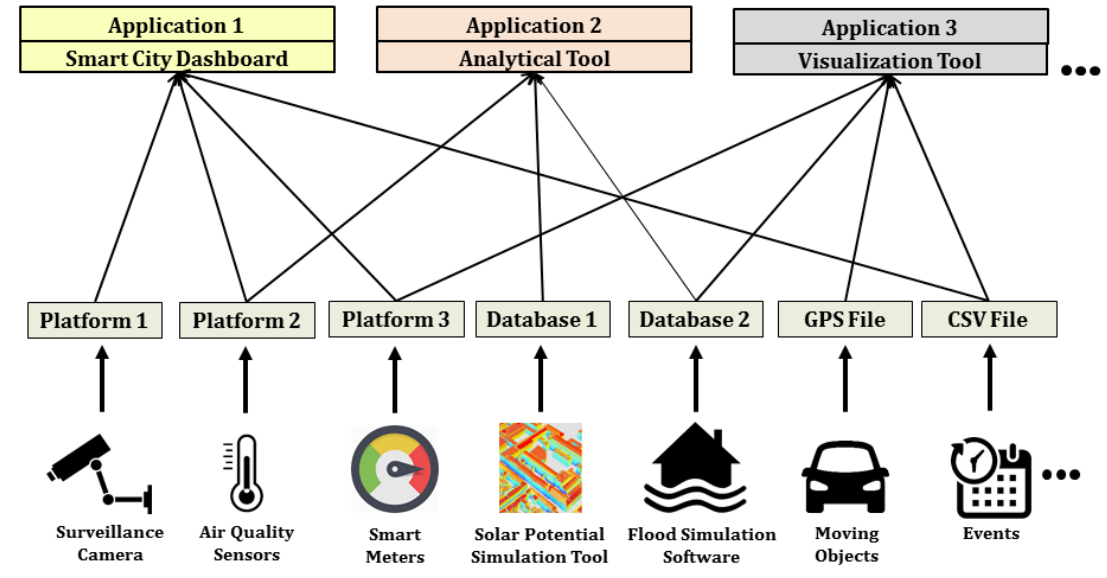
Figure 1. Illustration of heterogeneous data sources for sensor and timeseries data and the requirement to integrate and use them by common